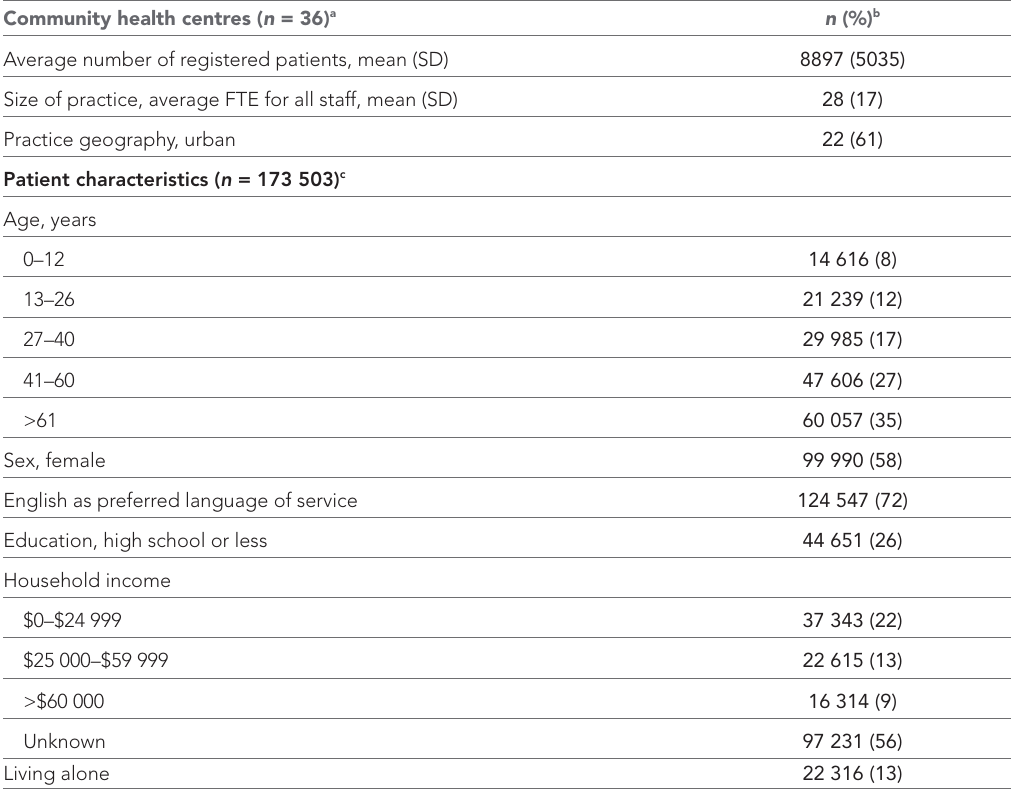
Table 1 Community health centres and patient